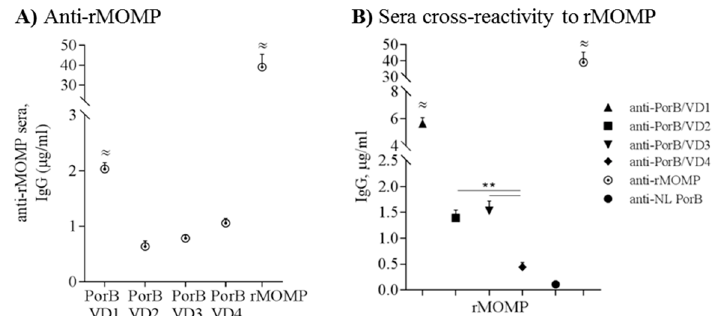
Figure 8. Antibodies to PorB/VDs and rMOMP are cross-reactive. ( A ) Anti-rMOMP (pooled mouse sera) tested against PorB/VDs and NL PorB by ELISA. IgG levels were measured in triplicate wells from two independent experiments and are expressed as µ g/mL ± SEM. ≈ p significant by one-way ANOVA with Tukey’s multiple comparisons test; ( B ) Sera tested against rMOMP as above. Anti-PorB/VD1: upward triangle; anti-PorB/VD2: square; anti-PorB/VD3: downward triangle; anti-PorB/VD4: diamond; anti-NL PorB: circle; anti-rMOMP: dotted circle (positive control). Sera from individual mice in each immunization group were tested in duplicate wells. ≈ p significant as above; ** p < 0.005 by Mann Whitney test.